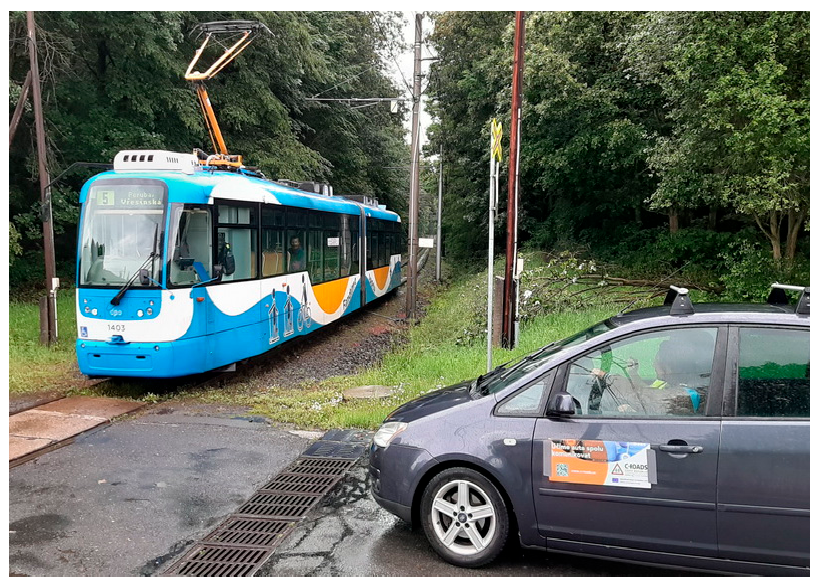
Figure 2. The test vehicle on the tram crossing under evaluation ride (point 3 on the map above).